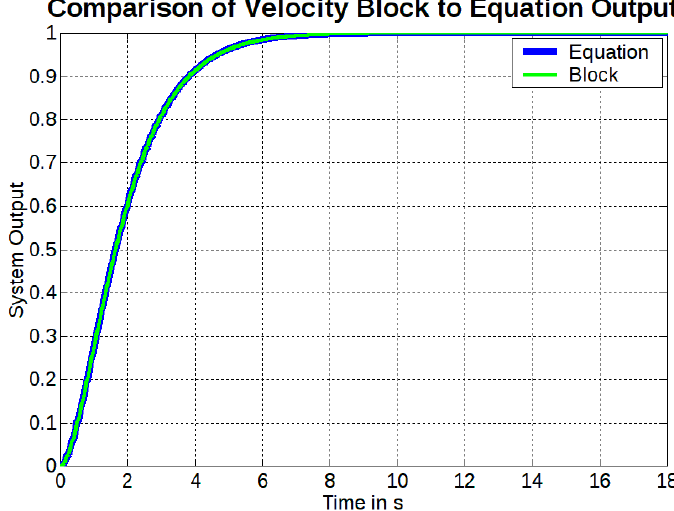
Figure 25. Verifying Velocity Form Control Implementation.